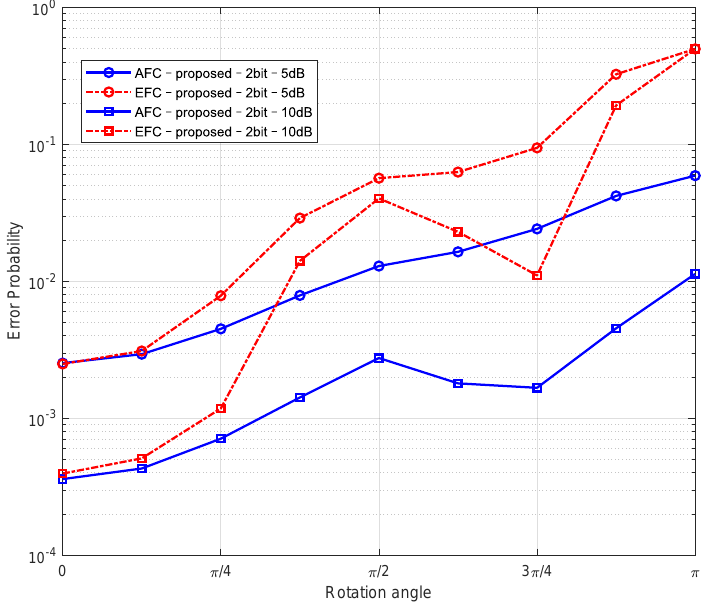
Figure 6. Error probabilities of the soft data fusion varying with φ for SNR = 5, 10 dB and snr L = 5